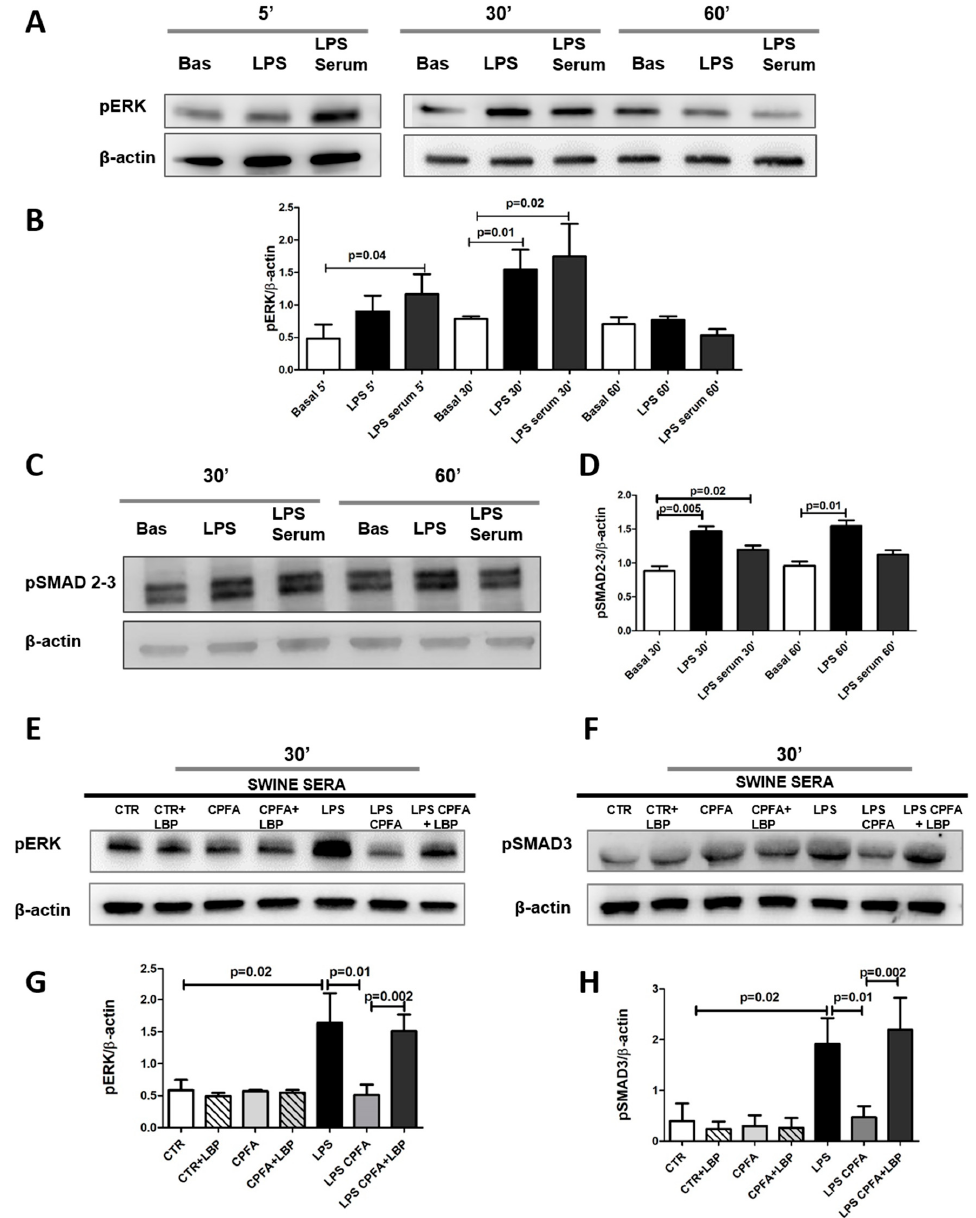
Figure 4. LPS and endotoxemic sera induced PMT by canonical TGF- β -SMAD2 / 3-dependent and non-canonical TGF- β -SMAD-independent signaling. ( A – D ) Pericytes were cultured with LPS or endotoxemic sera for 5, 30, and 60 min. Cell extracts were then used for WB analysis for pERK1 and pSMAD2 / 3. Both LPS and endotoxemic sera augmented SMAD2 / 3 and ERK1 phosphorylation, demonstrating the involvement of both canonical TGF- β -SMAD2 / 3-dependent and non-canonical TGF- β -SMAD-independent signaling. ( E – H ) Cultured pericytes were incubated in the presence of 1% of di ff erent swine sera for 30 min, with / without LBP (pre-treatment 1 h). CTR and CPFA-treated healthy sera maintained the phosphorylation of SMAD2 / 3 and ERK1 at basal level. Endotoxemic sera significantly increased phosphorylation of SMAD2 / 3 and ERK1. CPFA-treated endotoxemic sera reduced the phosphorylation of SMAD2 / 3 and ERK1 at basal level. The addition of LBP in CTR and CPFA-treated healthy sera did not augment phosphorylation of SMAD2 / 3 and ERK1. Otherwise, the addition of LBP in LPS CPFA sera reversed CPFA e ff ects, increasing the activation of SMAD2 / 3 and ERK1. Results are representative of three independent experiments. Data are shown as mean ± standard deviation (SD) and compared with the Student t